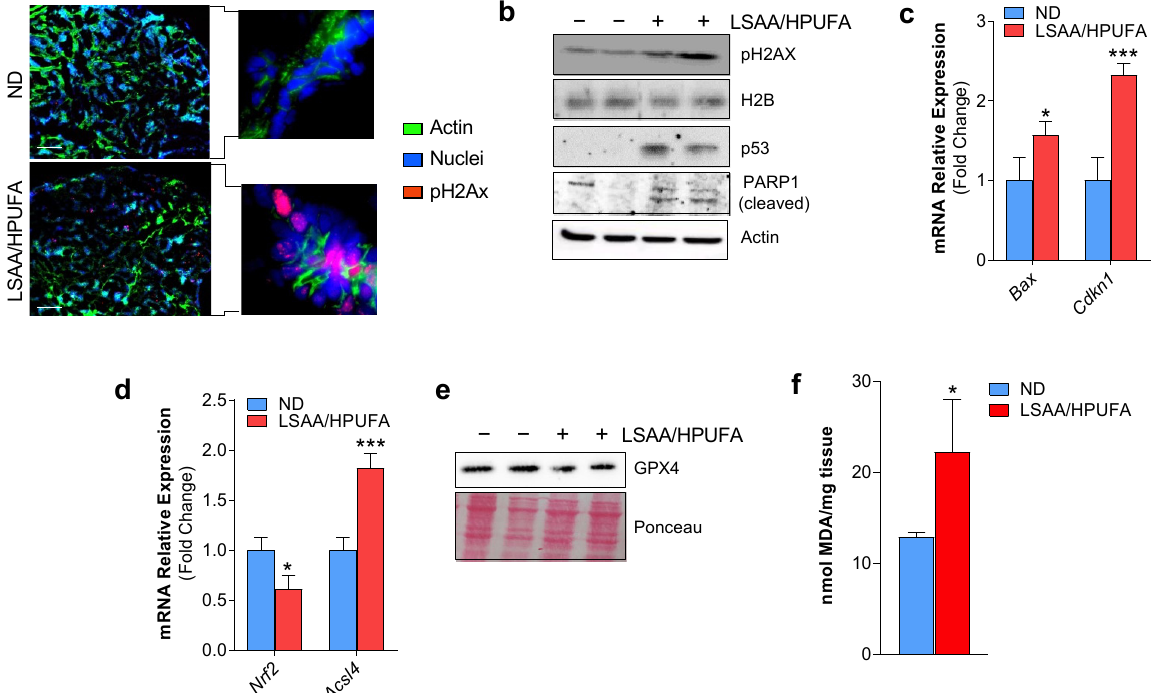
Figure 4. Reducing sulfur amino acids (SAAs) and increasing peroxidizable polyunsaturated fatty acids (PUFAs) through diet induces apoptosis and ferroptosis in breast cancer. ( a ) Representative immunofluorescence images of nuclear DNA damage detected by using pH2AX antibody in explanted breast cancer masses from low SAA–high PUFA (LSAA/HPUFA) or normal diet (ND) group. Incubation with AlexaFluor488-conjugated phalloidin and Hoechst 33342 were used to visualize actin cytoskeleton and nuclei, respectively. Scale bar: 100 µ m. ( b ) Western blot analysis of pH2AX, p53 and PARP1 in explanted tumor masses. H2B and Actin were used as loading controls. ( c , d ) RT-qPCR analysis of the mRNA expression of the p53 downstream apoptosis-related genes Bax and Cdkn1 ( c ) and ferroptosis-related genes Nrf2 and Acsl4 ( d ). ( e ) Western blot analysis of GPX4 in explanted tumor masses. Ponceau red staining was used as loading control. ( f ) Measurement of malondialdehyde (MDA) levels in explanted tumor masses through a colorimetric assay. All the immunoblots reported are from n = 2 mice out of n = 6 mice/group yielding similar results. Data are expressed as mean ± S.D. ( n = 9 mice/group; *** p < 0.001, * p < 0.05 vs. ND).